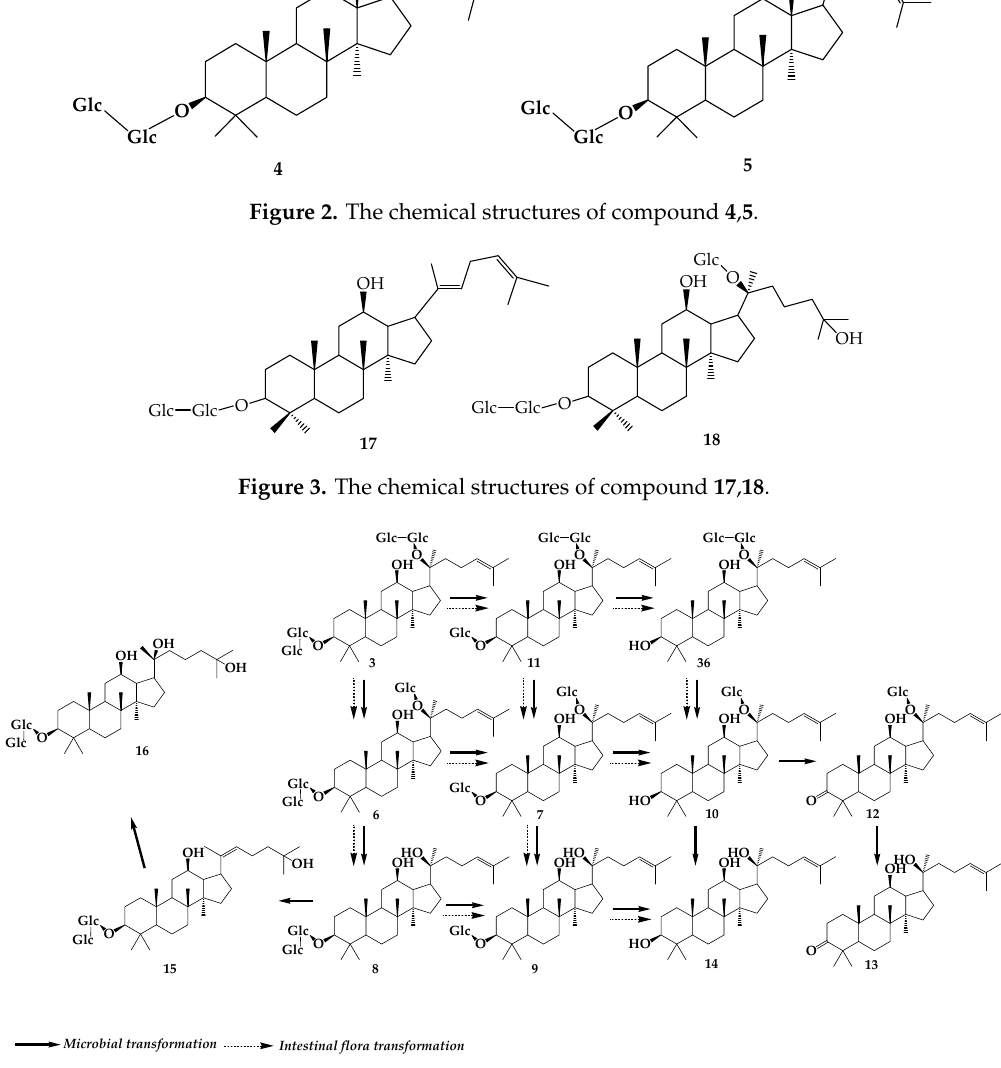
Figure 4. Ginsenoside transformation pathway.